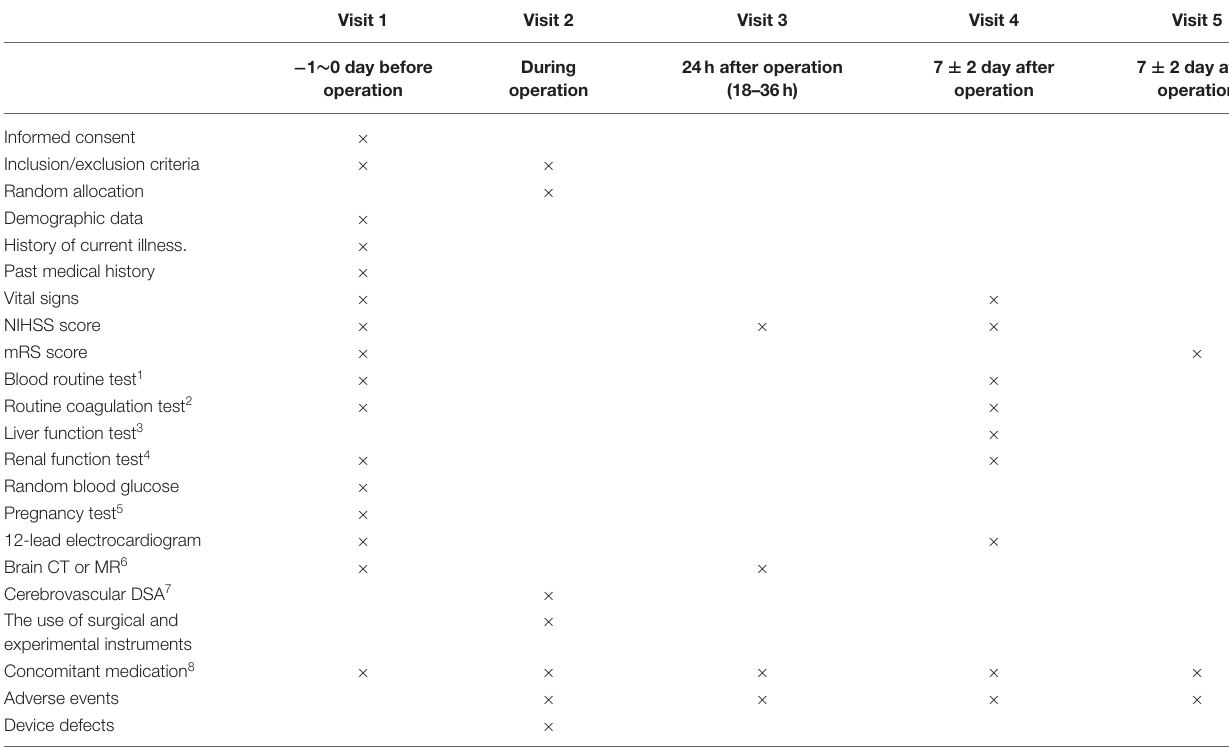
massive cerebral infarction or angiemphraxis before the interventional procedure, and whether there is intracranial hemorrhage after procedure; 7 cerebrovascular DSA: identify whether there is initial carotid artery occlusion, carotid artery dissection or arteritis, whether there is a tortuous vessel path that makes it difficult for the test/control device to reach the target position, the target vessel and the diseased segment, the proximal diameter of the occluded vessel, mTICI before, and after the operation; 8 record the use of anticoagulant, antiplatelet drugs, and drug for adverse